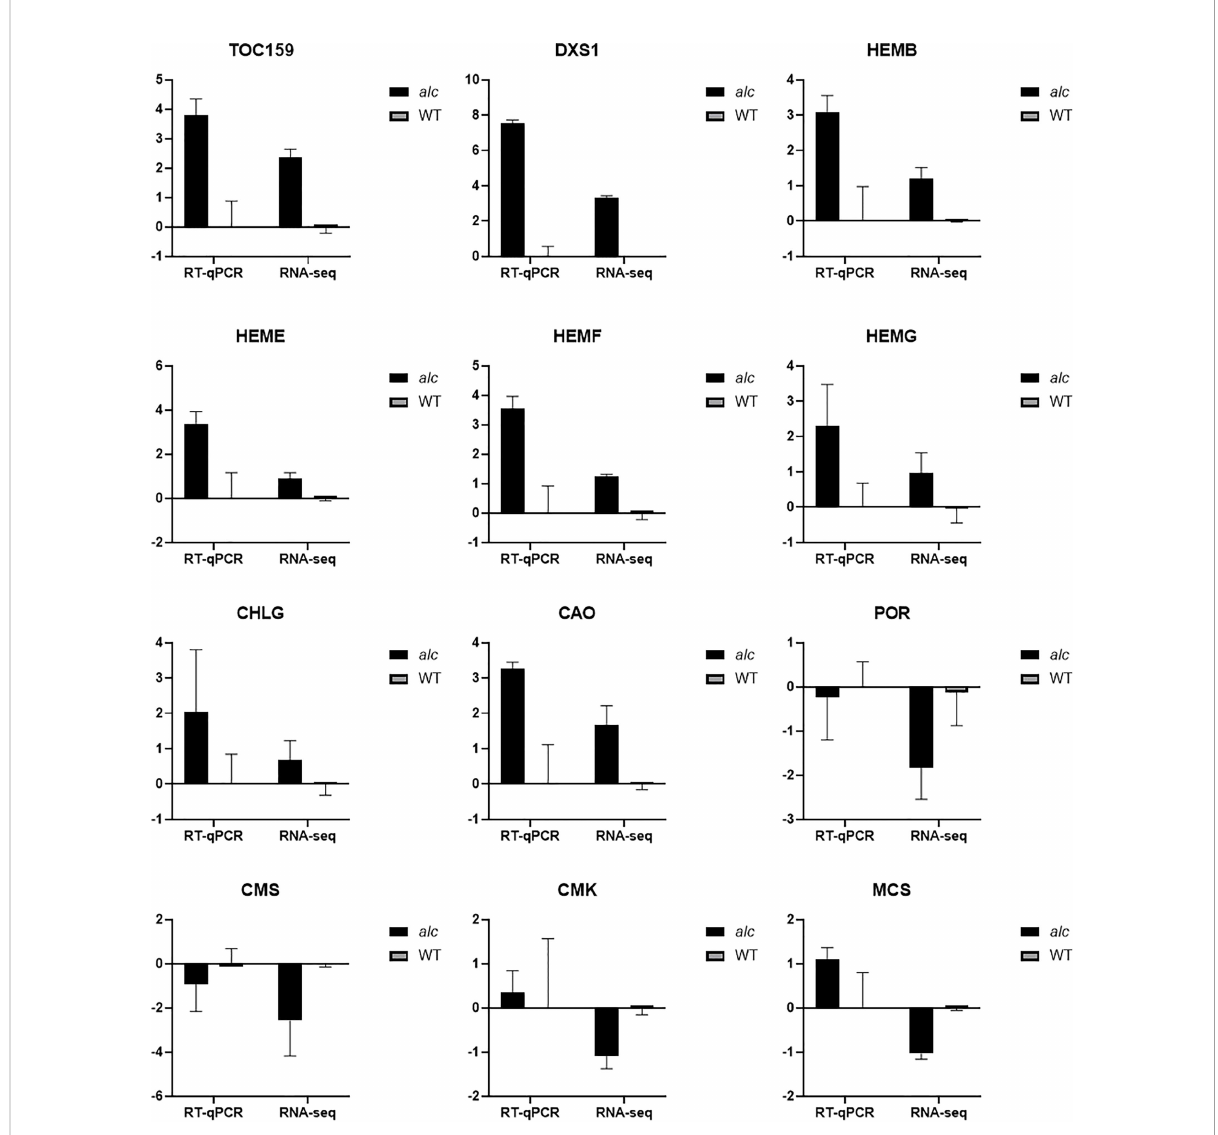
FIGURE 6 Expression pro fi le of selected differentially expressed genes between alc mutant and wild type from RNA-seq result achieved by qRT-PCR. X- axis represented gene name and y-axis represented relative expression ( – DD Ct) value of each gene. Data are shown as means (n = 3). Error bars indicated standard